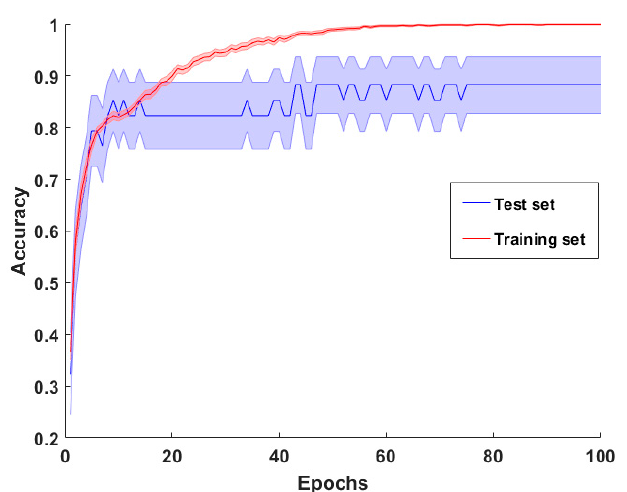
Figure 9. 3D ‐ DCNN average (and related standard error) cross ‐ validated accuracy as a function of Figure 9. 3D-DCNN average (and related standard error) cross-validated accuracy as a function of the training epoch for the training and the testing set, respectively. the training epoch for the training and the testing set, respectively.